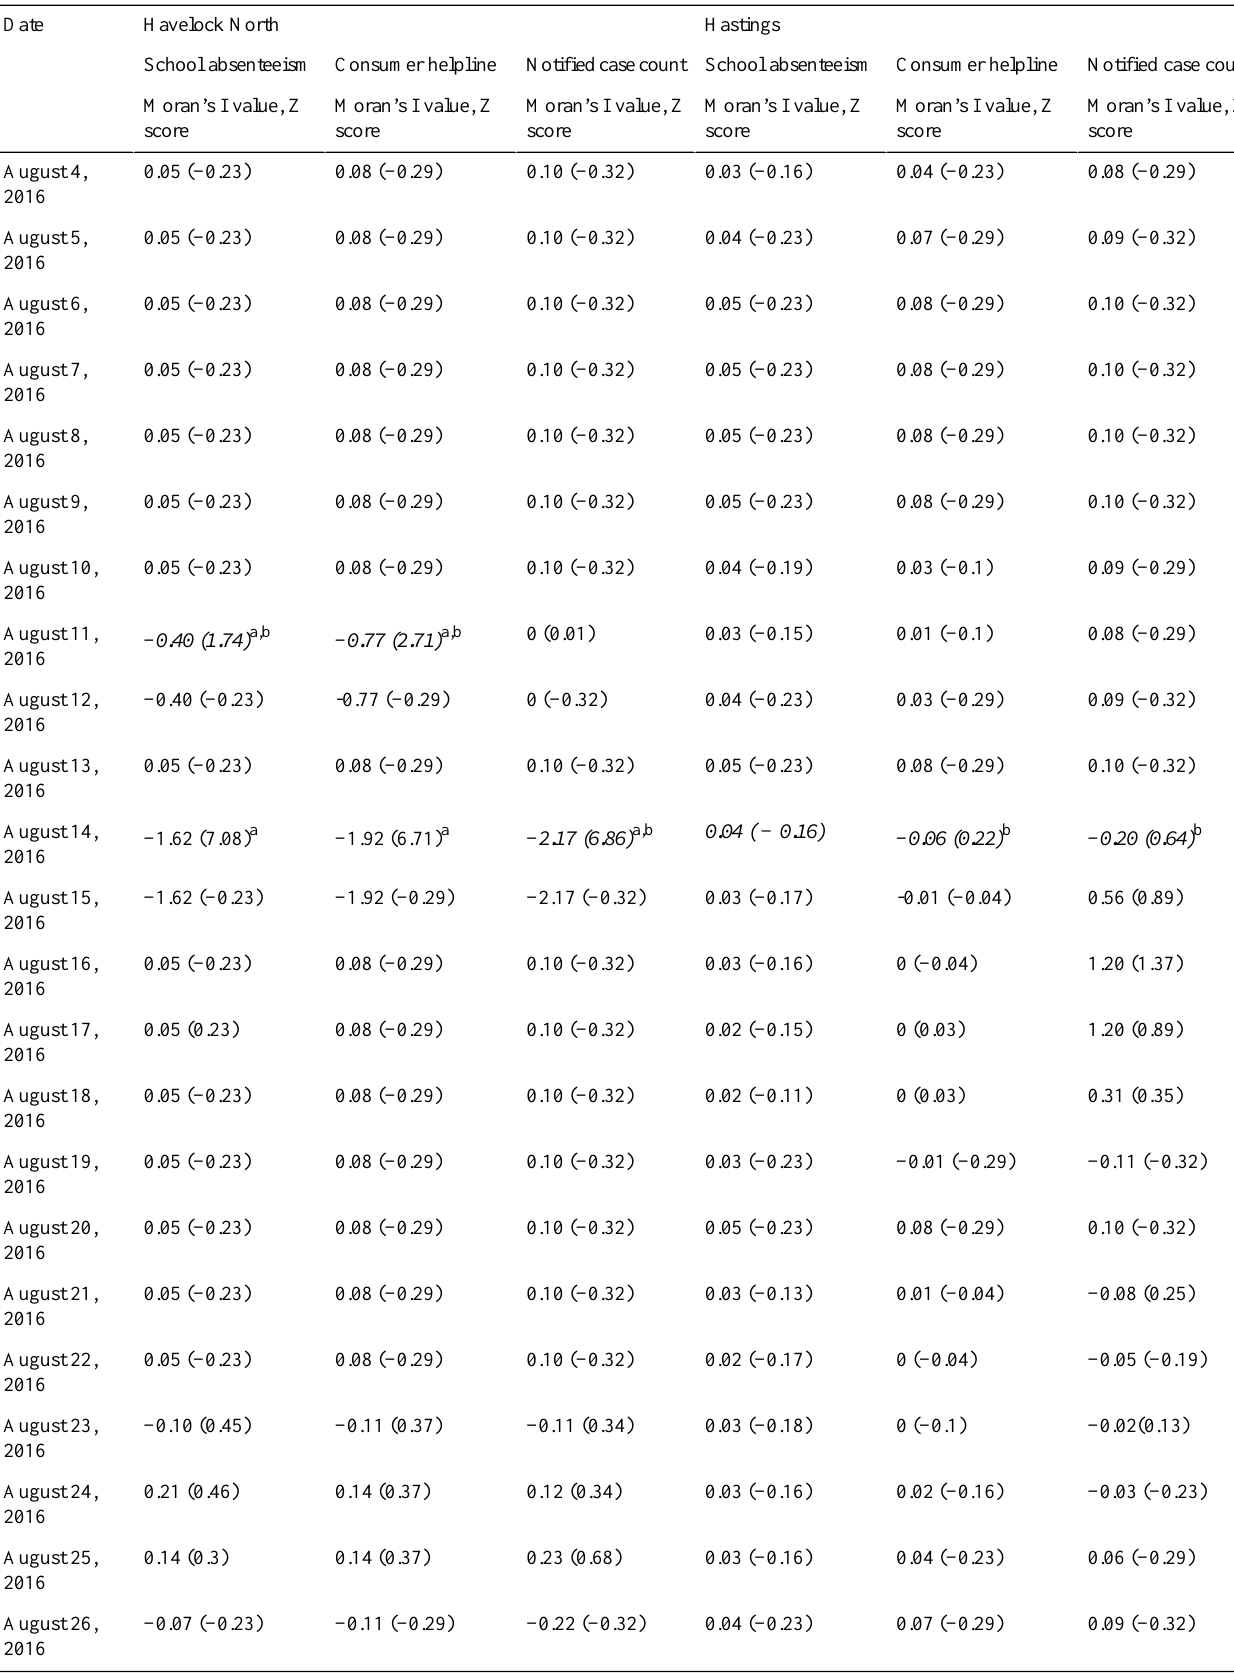
Table 5. Daily Local Moran’s I in school absenteeism, consumer helpline inquiries, and notified case counts in Havelock North and Hastings cities in August 2016. HastingsHavelock